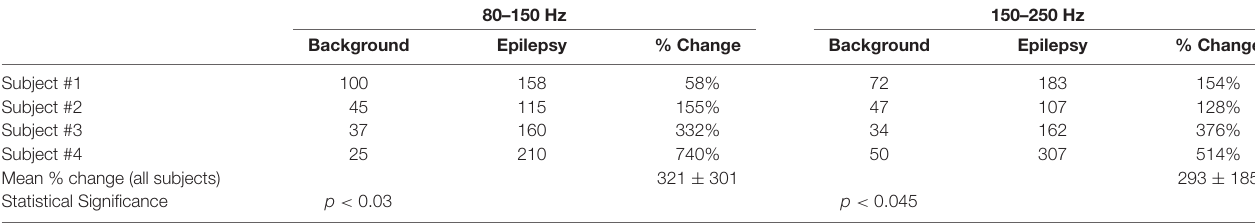
TABLE 1 | Change in peak value of the phase cone rate (counts/s) in the epileptogenic zone as compared with the nearby background